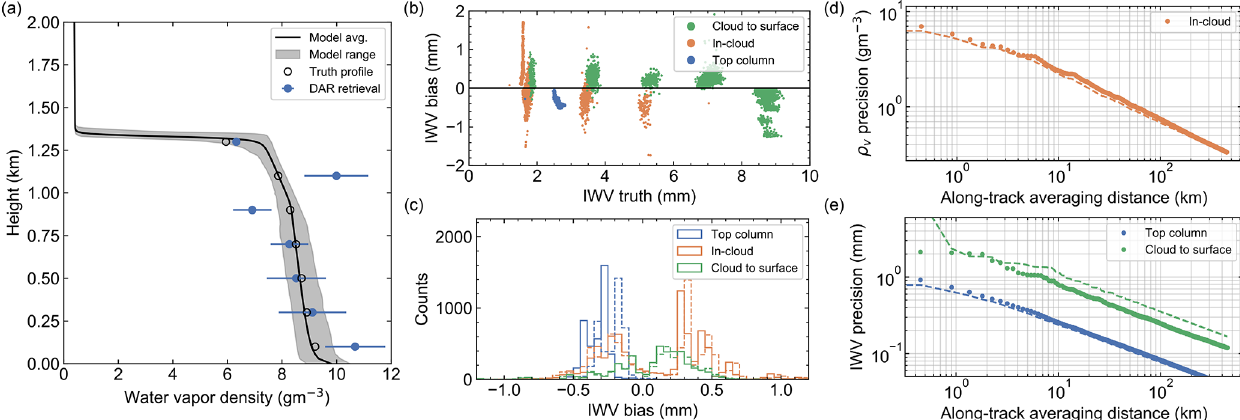
Figure 9. VOCALS DAR retrieval results. Panels (a) , (b) , (d) , and (e) are as in Figs. 5 and 7, while panel (c) shows retrieval bias histograms for H ρ = 1 . 5km (solid lines) and H ρ = 2 . 5km (dashed lines). In panels (d) and (e) , note the insensitivity of the precision to choice of scanning strategy (circles: fixed nadir, dashed line: intelligently scanned) because of the horizontal uniformity of the cloud